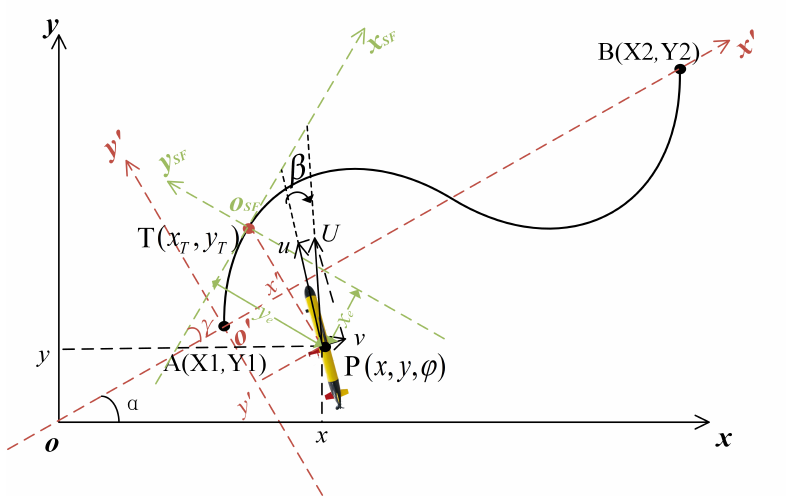
Figure 2. Path following error